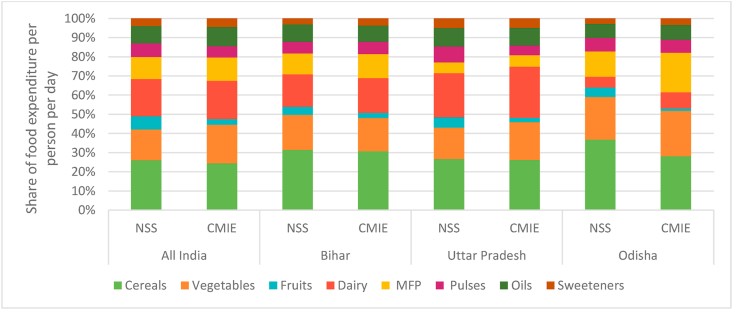
Comparison of share of food expenditures between 2011–12 and 2018–19.